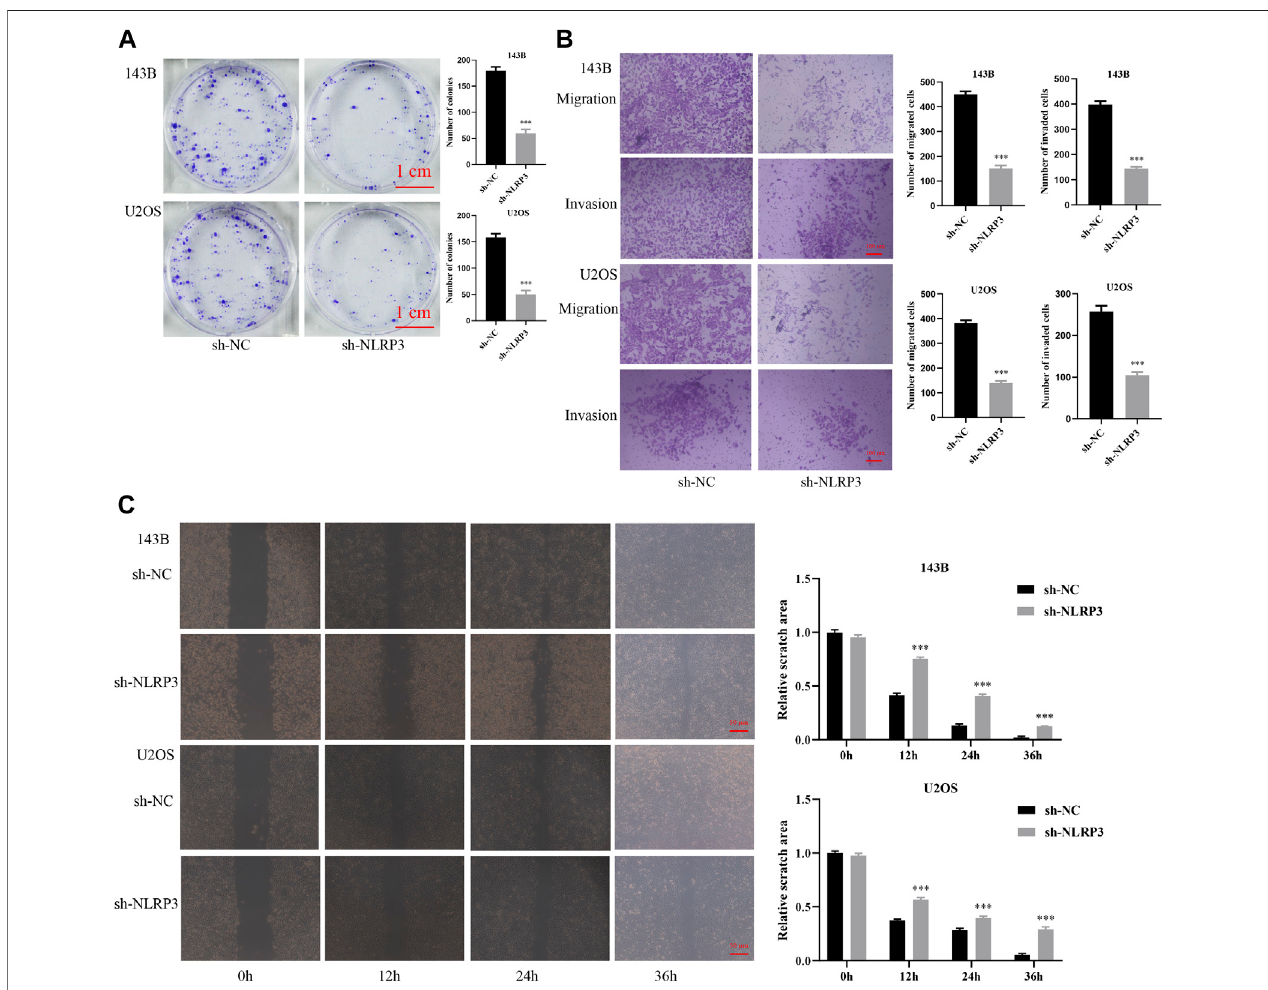
FIGURE 4 | Effect of NLRP3 knockdown on the proliferation, migration, and invasion of 143B and U2OS cells (A) Cell proliferation of lentivirus-transfected 143B and U2OS cells detected by colony formation assay after incubation for seven days (B) Cell migration and invasion of lentivirus-transfected 143B and U2OS cells examined using the transwell assay (C) Cell migration of lentivirus-transfected 143B and U2OS cells detected using the wound healing assay after incubation for 0, 12, 24, and 36 h. The experiments were carried out in triplicate.